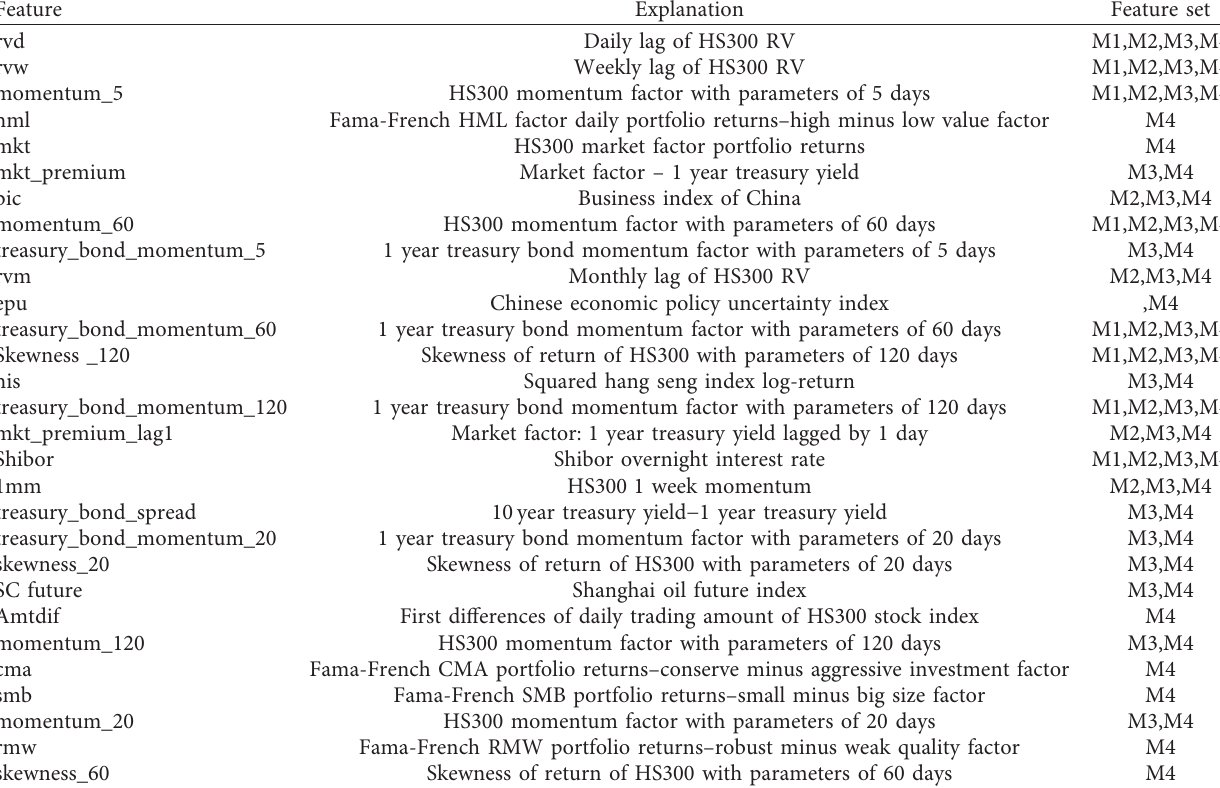
Table 1: Name, description, and data set of 30